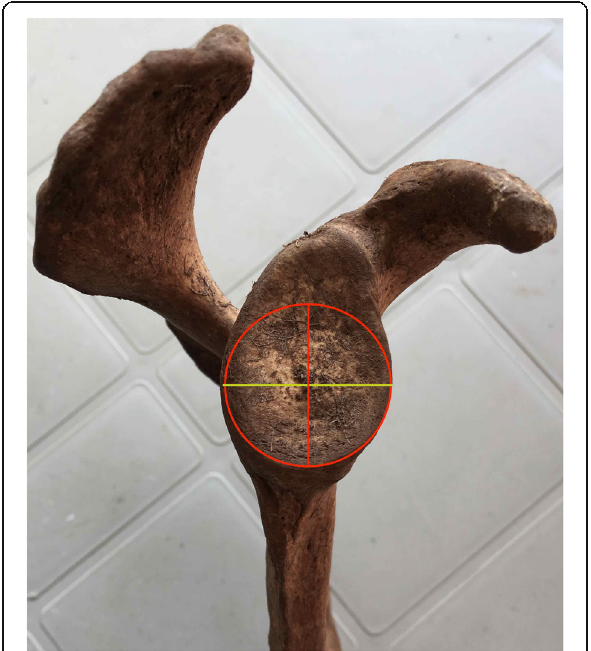
Fig. 3 The hypothetical glenoid bone loss was calculated using the Diameter-Based Method as follows: Percent bone loss = (Defect width/Diameter of inferior glenoid circle) ×